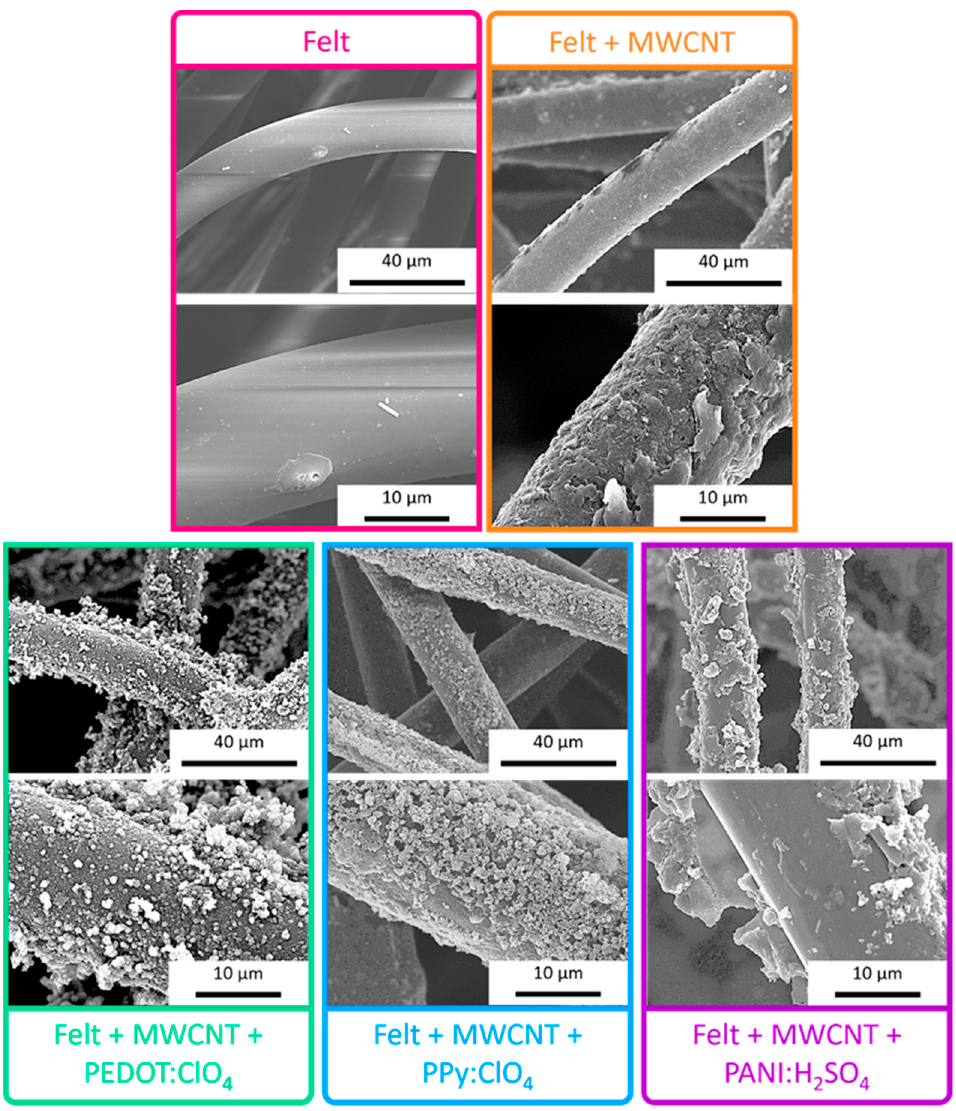
Figure 5. SEM images of uncoated felt fabric, felt-MWCNTs fabric, and felt-MWCNTs-PEDOT:ClO 4 , felt-MWCNTs-Ppy:ClO 4 , and felt-MWCNTs-PANI:H 2 SO 4 fabrics. Raman spectroscopy was conducted to obtain information about the composition of the felt fibers coating. Figure 6 shows the Raman spectra of the pristine fabric and the fabric with the different coatings. The main peaks of each sample have been marked with points. The assignation of peaks is detailed in Table 1.